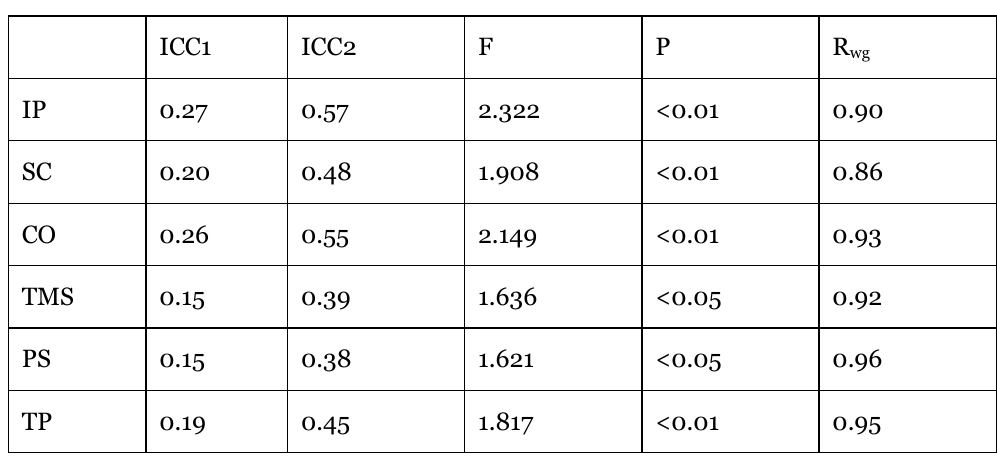
Results of Team Level Reliability and Validity